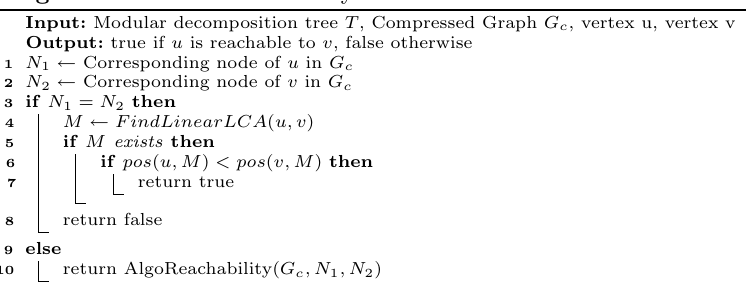
Algorithm 4: Find reachability from vertex u to vertex